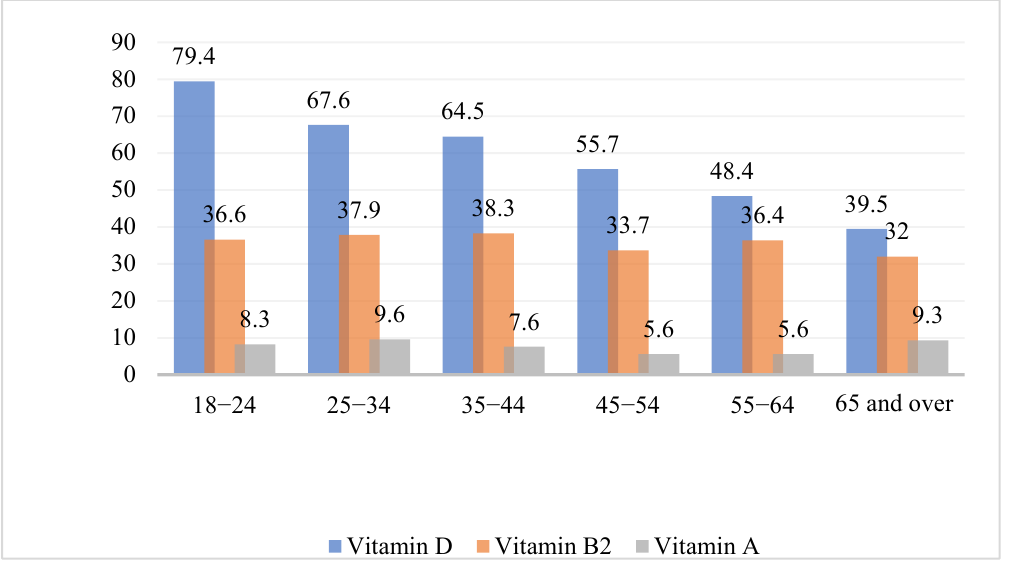
Figure 1. Distribution of vitamin D, B2, and A deficiencies based on age group.